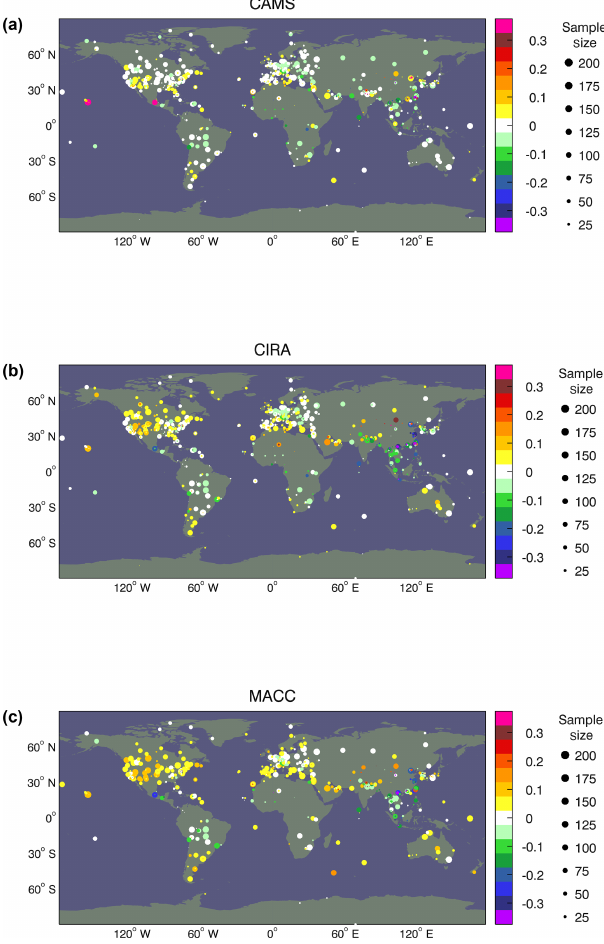
Figure 21. Mean Total AOD bias between the three reanalyses and AERONET observations for (a) CAMSRA, (b) CIRA and (c) MACCRA. For CAMSRA and CIRA the average is calculated over the period 2003–2016, and for MACCRA it is calculated only for 2003–2012. AOD is